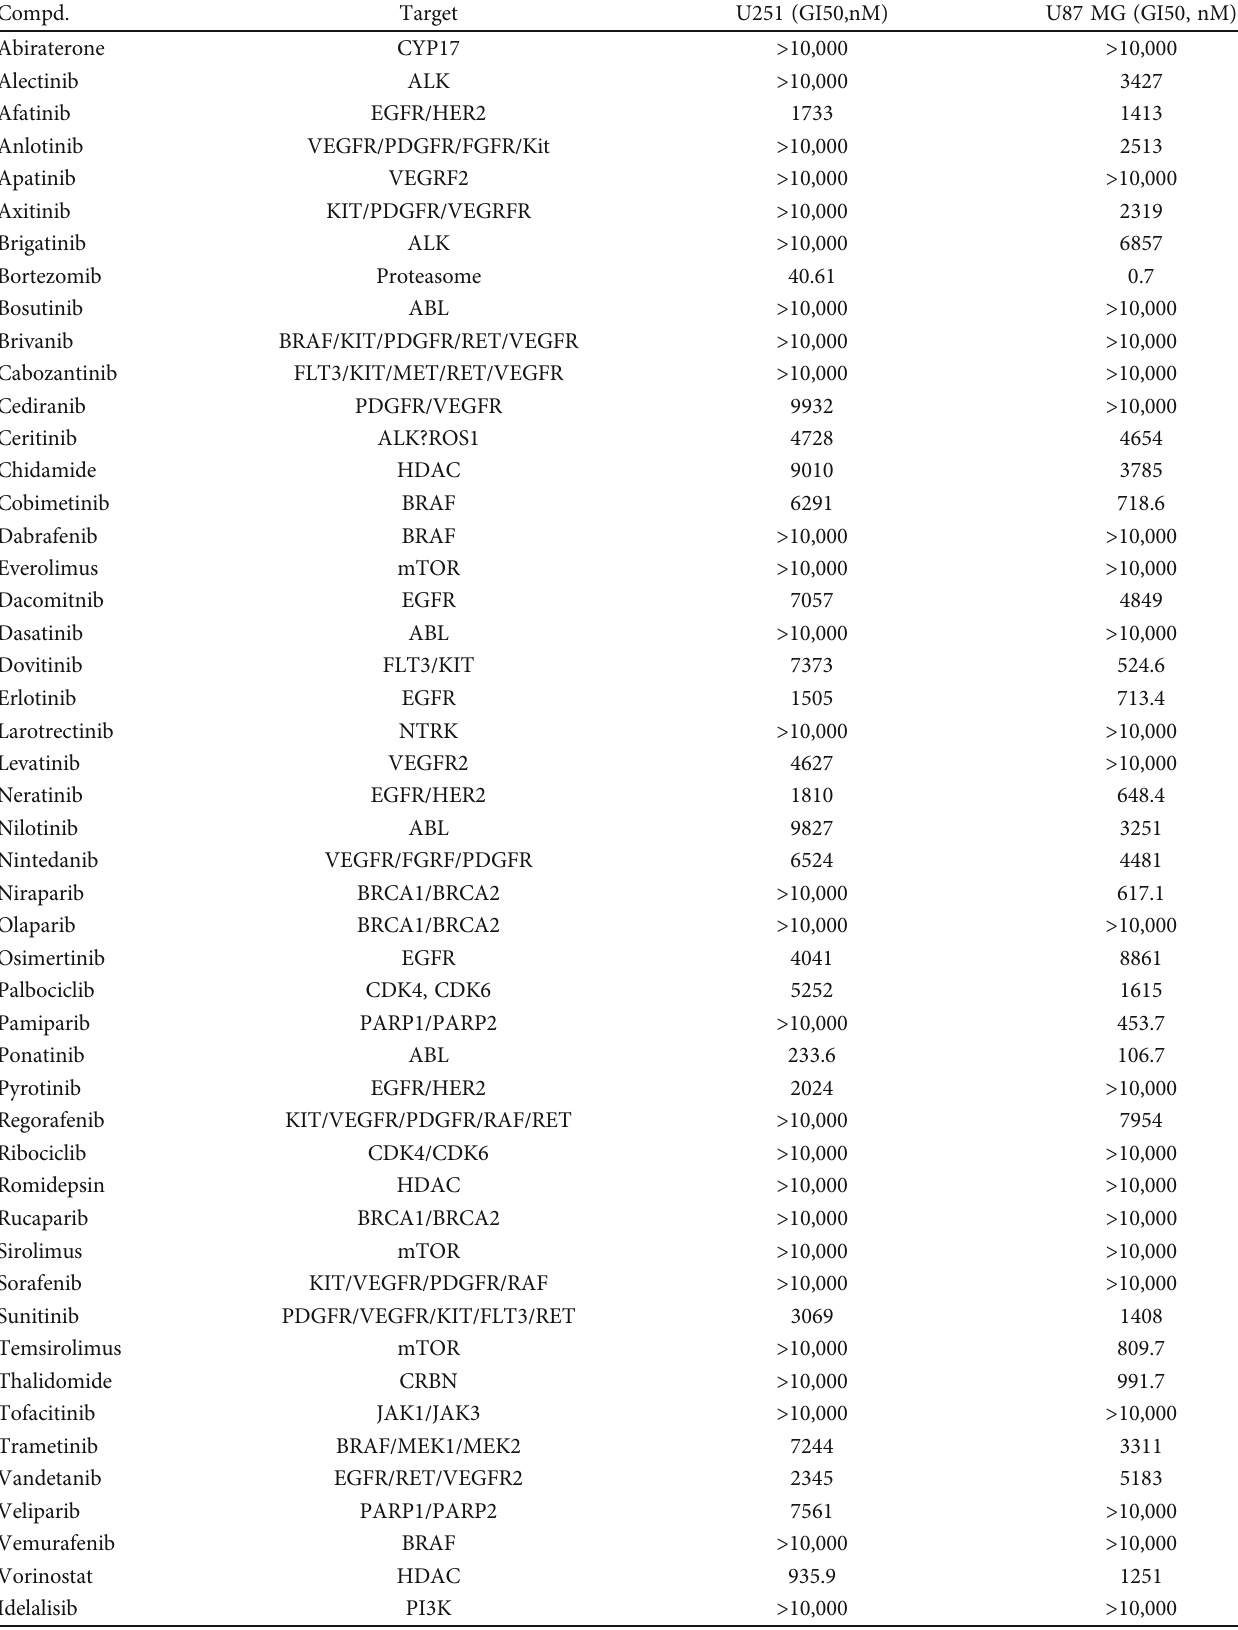
Table 1: The test of compounds targeting on